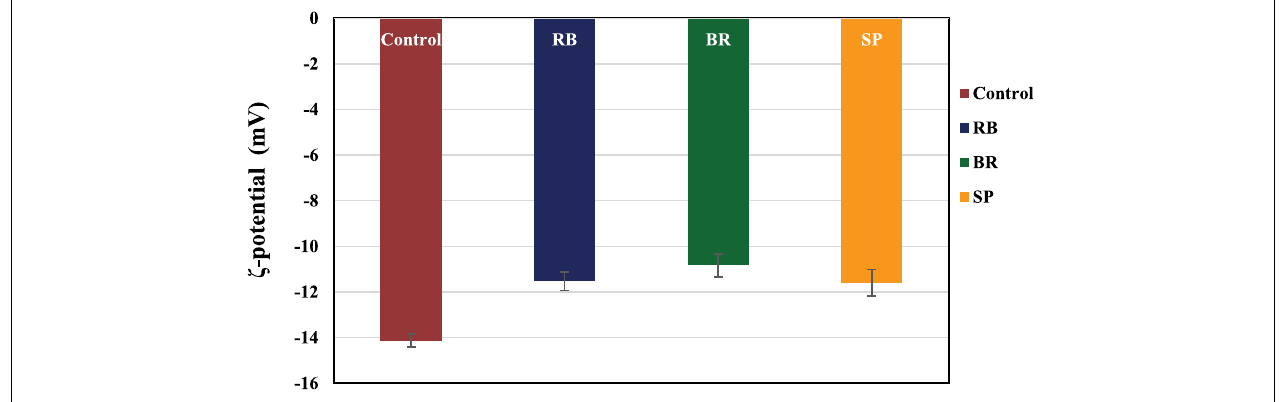
FIGURE 1 | ζ -Potential of control (without phenolic extract), red beet (RB), broccoli (BR), and spinach leaf (SL) complex coacervate microcapsules.